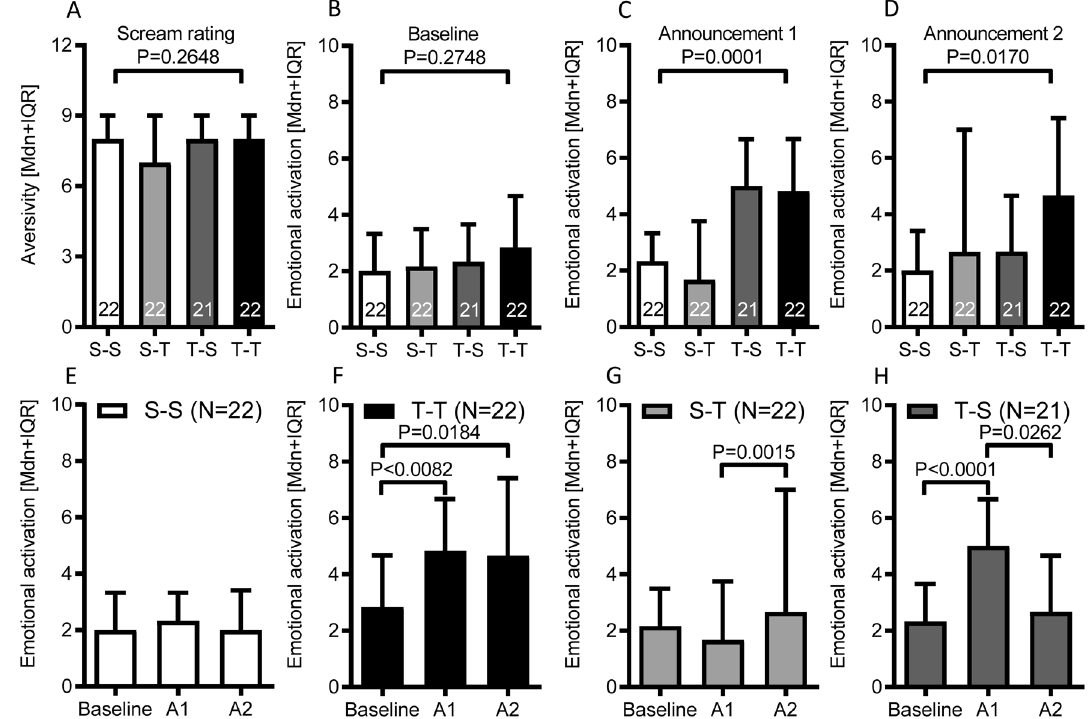
Figure 2. Validation of the online version of the threat of scream paradigm as a tool to induce experimental anxiety. ( A ) Distress scream rating: Subjective rating of the aversiveness of the selected distress scream on a visual analogue scale. ( B–D ) Emotional activation: Sum scores of subjective ratings (on visual analogue scales) of the current level of anxiety, stress and emotional arousal prior to the start of the experiment (Baseline), after the first or second announcement of threat or safety conditions. Each bar represents the median and interquartile range [Mdn + IQR] of corresponding visual analog scale ratings. Numbers within the bars indicate the sample size of the experimental condition. P -values given refer to Kruskal–Wallis tests for independent samples. Abbreviations: S-S: Safety-Safety condition; T-T: Threat-Threat condition; S-T: Safety-Threat condition; T-S: Threat-Safety condition. ( E–H ) Within-group dynamics of emotional activation during the baseline measurement and after threat or safety announcements for the four experimental conditions. Each bar represents the median and interquartile range [Mdn + IQR] of corresponding visual analog scale ratings. P -values given refer to Wilcoxon signed rank tests for dependent samples. Abbreviations: S-S: Safety-Safety condition; T-T: Threat-Threat condition; S-T: Safety-Threat condition; T-S: Threat-Safety the subjective emotional state prior to threat or safety announcements, was comparable across groups and experi- mental conditions. As hypothesized, the reported emotional activation (that has been measured immediately after the end of the passive walkthrough videos) after the first and second threat vs. safety announcements was significantly different across experimental conditions (Announcement 1: χ 2[3] = 21.06, P < 0.0001; Announce- ment 2: χ 2[3] = 10.10, P = 0.0170; Kruskal–Wallis test; Fig. 2C,D). Emotion induction in the safety-safety and threat-threat groups. As expected, within-group comparisons between the 3 measurements (Baseline vs. Announcement 1: W = 27; P = 0.5382; Baseline vs. Announcement 2: W = 8; P = 0.8732; Announcement1 vs. Announcement 2: W = − 21; P = 0.6614; Wilcoxon test; Fig. 2E) indicated that the subjective emotional activation induced by the two Safety announcements was not significantly different from the baseline measurement in the Safety-Safety group. The emotional activation of the Threat-Threat group was significantly higher after the first and second announcements relative to the baseline condition (Baseline vs. Announcement 1: W = 148; P = 0.0082; Baseline vs. Announcement 2: W = 143; P = 0.0184; Wilcoxon test; Fig. 2F). No significant difference was found for the comparison of the emotional activation induced by the first and second announcement. (Announcement1 vs. Announcement 2: W = 28; P = 0.6387; Wilcoxon test; Fig. 2F). The subjective emotional activation during the baseline measurement was not significantly different between the Safety-Safety and Threat-Threat groups (U = 167; P = 0.0779; Mann–Whitney U test; Fig. 2E,F). As expected, the emotional activation induced by the first announcement was significantly higher in the Threat-Threat group as compared to the Safety-Safety group (U = 118; P = 0.0029; Mann–Whitney U test; Cohen’s d = 0.9866; effect size r = 0.4424; Fig. 2E,F). Similarly, after the second announcement, the subjective emotional activation was significantly higher in the Threat-Threat group as compared to the Safety-Saftey group (U = 112.5; P = 0.0018; Mann–Whitney U test; Cohen’s d = 1.0221; effect size r = 0.4551; Fig. 2E,F).